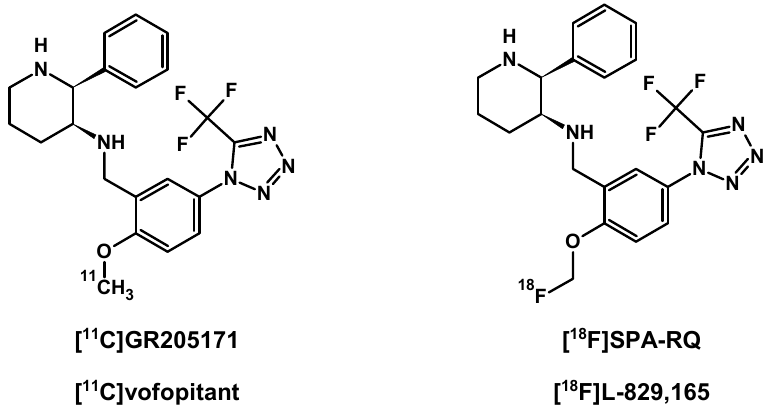
Figure 5. Twin structures of radiotracers [ 11 C]GR205171 and [ 18 F]SPA-RQ.